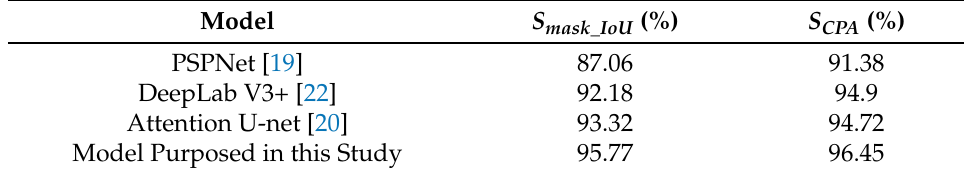
Table 4. Comparison of S mask _ IoU and S CPA from different segmentation